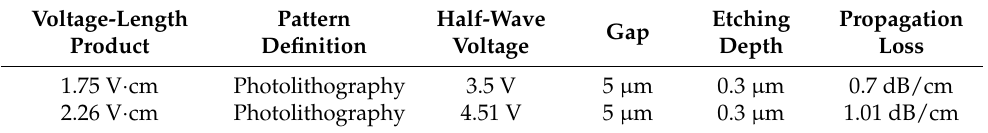
Table 1. Performance comparison of TFLN